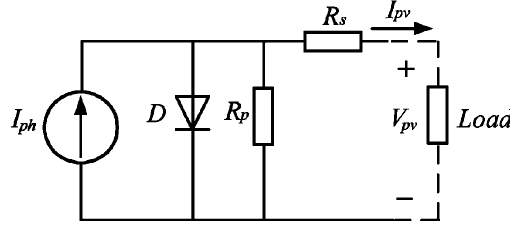
Figure 2. Equivalent circuit of a photovoltaic cell.